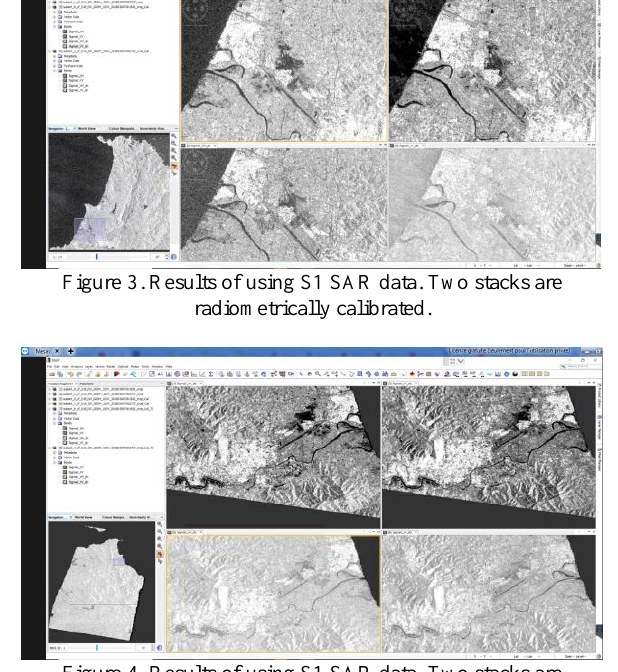
Figure 4. Results of using S1 SAR data. Two stacks are corrected geometrically.